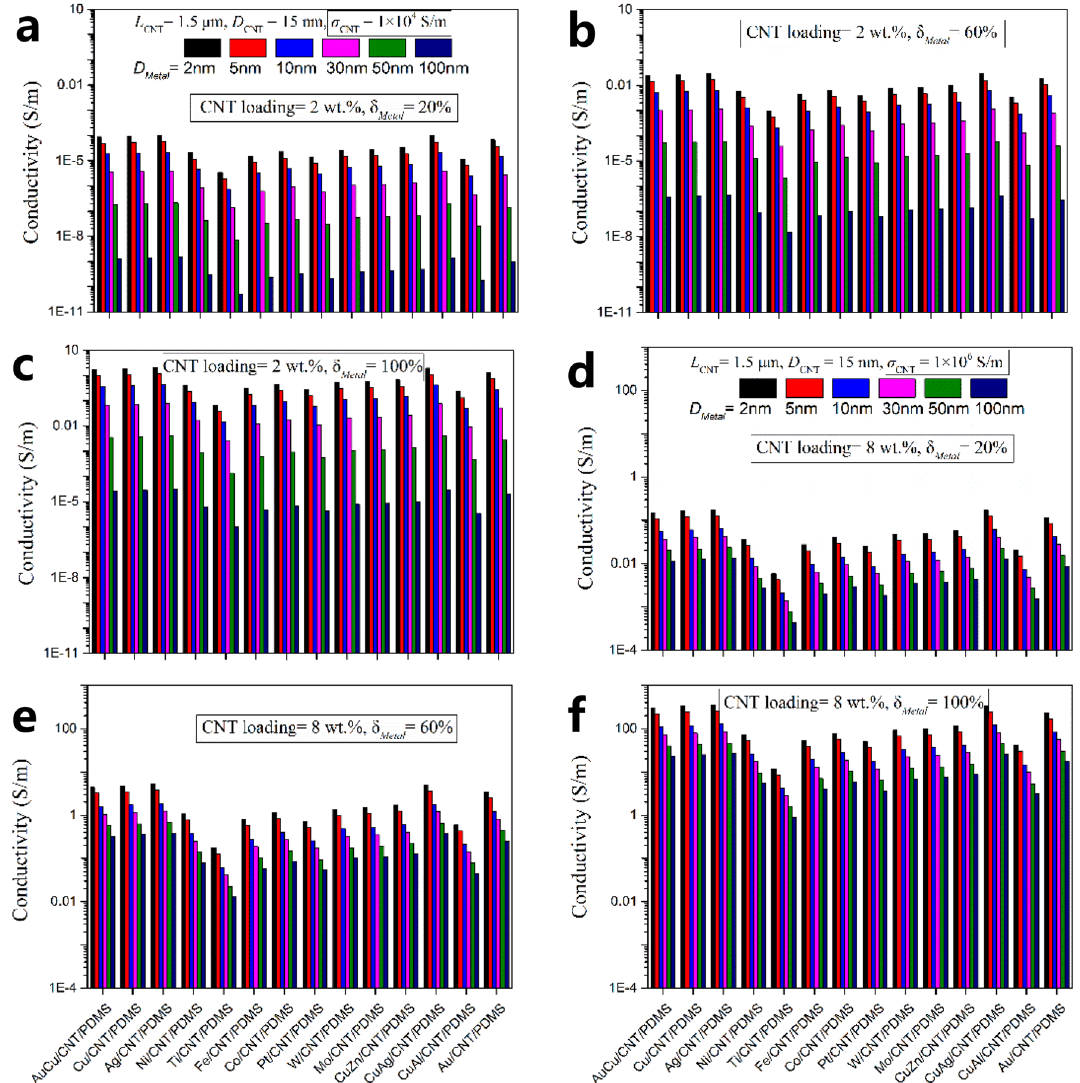
Figure 7. Calculation and simulation results of conductivity on Metal/CNT/PDMS films with various metal and alloys coated on tubes, various CNT loadings, various metal coverage ratio and various intrinsic conductivity of CNT. ( a ) σ cnt = 10 4 S/m, CNT loading = 2 wt.%, δ Metal = 20%. ( b ) σ cnt = 10 4 S/m, CNT loading = 2 wt.%, δ Metal = 60%. ( c ) σ cnt = 10 4 S/m, CNT loading = 2 wt.%, δ Metal = 100%. ( d ) σ cnt = 10 6 S/m, CNT loading = 8 wt.%, δ Metal = 20%. ( e ) σ cnt = 10 6 S/m, CNT loading = 8 wt.%, δ Metal = 60%. ( f ) σ cnt = 10 6 S/m, CNT loading = 8 wt.%, δ Metal =